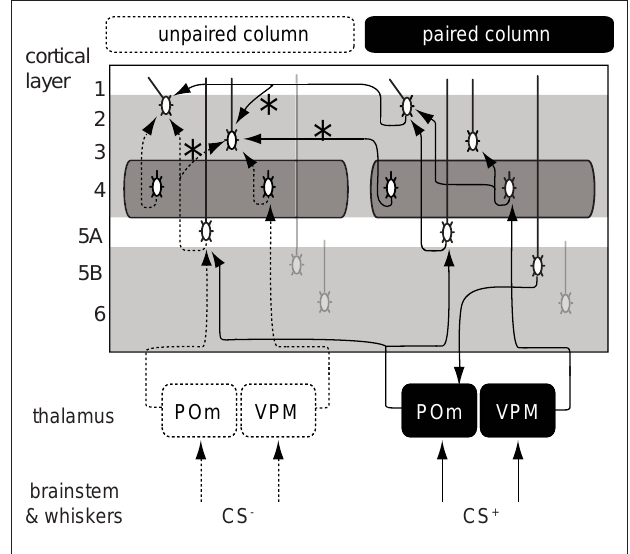
Figure 5 | Proposed cortical circuits underlying an enlarged representation of CS + in barrel cortex. In solid lines, the projections with inputs from a paired whisker (CS + ) and in dashed lines, the projections with inputs from an unpaired whisker (CS − ). Stars indicate projections that were strengthened after conditioning. CS + inputs could directly reach the L2/3 of the CS column through transcolumnar circuitries with